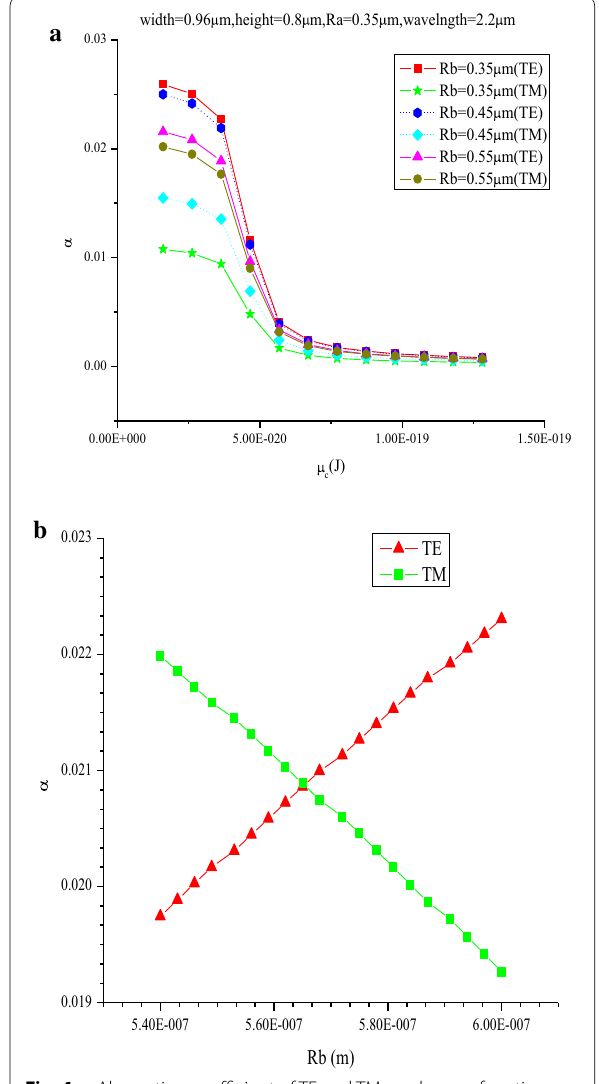
Fig. 4 a Absorption coefficient of TE and TM modes as a function of μ c at different Rb, (wavelength absorption coefficient of TE and TM modes as a function of Rb (Ra 0.35 μm, wavelength =